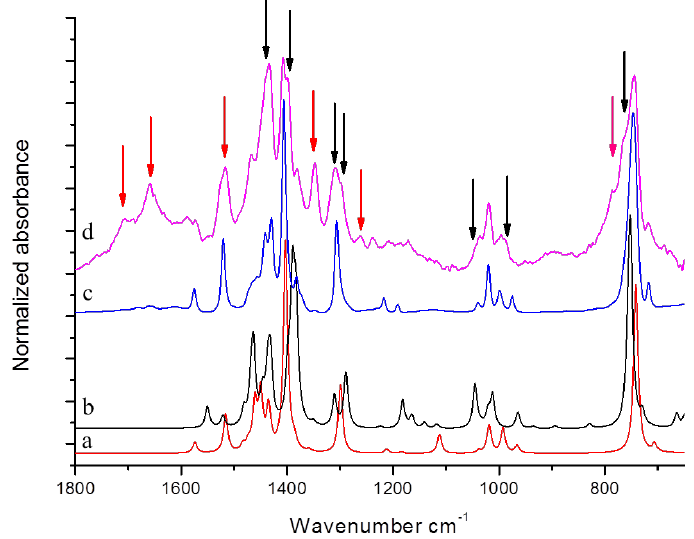
Figure 6. DFT computed spectrum of: TMP ( a ) and of α - α (cid:48) dimer of TMP (DMP) 2 ( b ). Experimental spectra of pristine TMP ( c ) and the reference spectrum of modified TMP-sample treated at 130 ◦ C in the absence of HSAG, spectrum recorded after TMP evaporation ( d ). Black and red arrows indicate absorption features which can be rationalized with the occurrence of (DMP) 2 and TMP oxidized species respectively. By directly comparing spectra (c) and (d) in Figure 6, it is possible to clearly detect new features due to TMP derivatives formed by the thermal